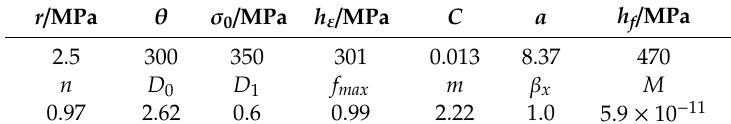
Table 2. Parameters of the proposed constitutive model.